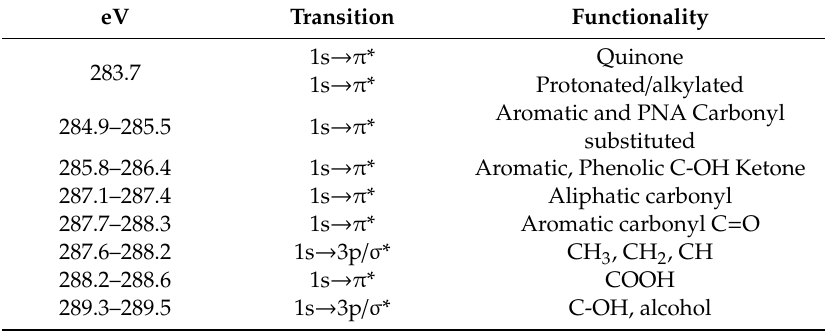
Table 3. NEXAFS transition energy of electrons of C(1s) to π * molecular orbital and typically observed peak position of common chemical functionality (Reproduced from Reference [118] with permission from